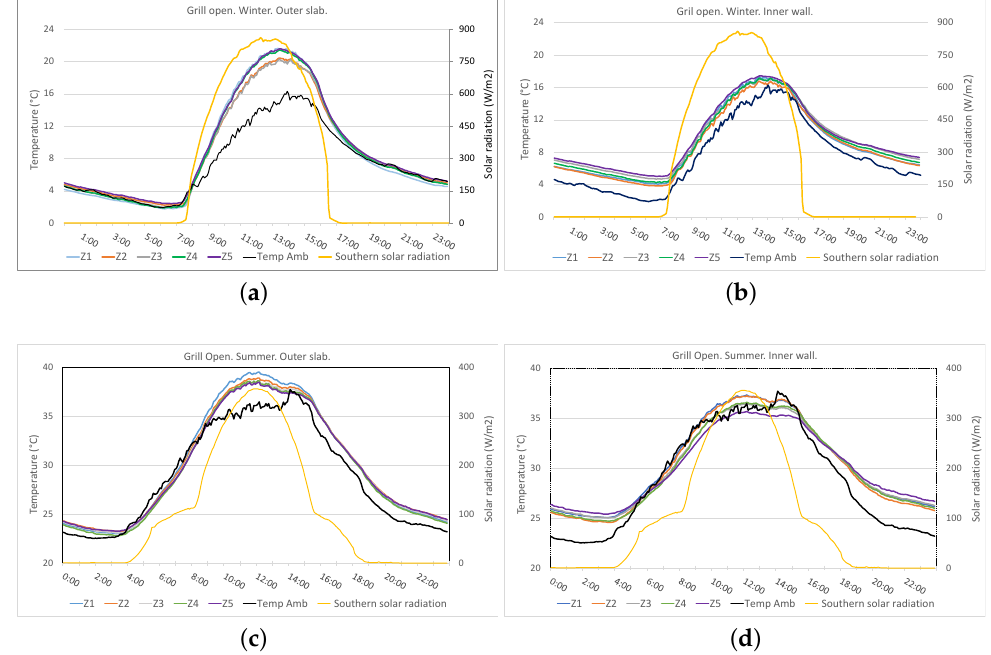
Figure 11. Open ventilation grills. Evolution of the measured temperatures of the air cavity surfaces for a winter day (14 January 2021): ( a ) exterior slab, ( b ) inner wall; and a summer day (5 July 2021): ( c ) exterior slab, ( d ) inner wall. South solar radiation and ambient temperatures are